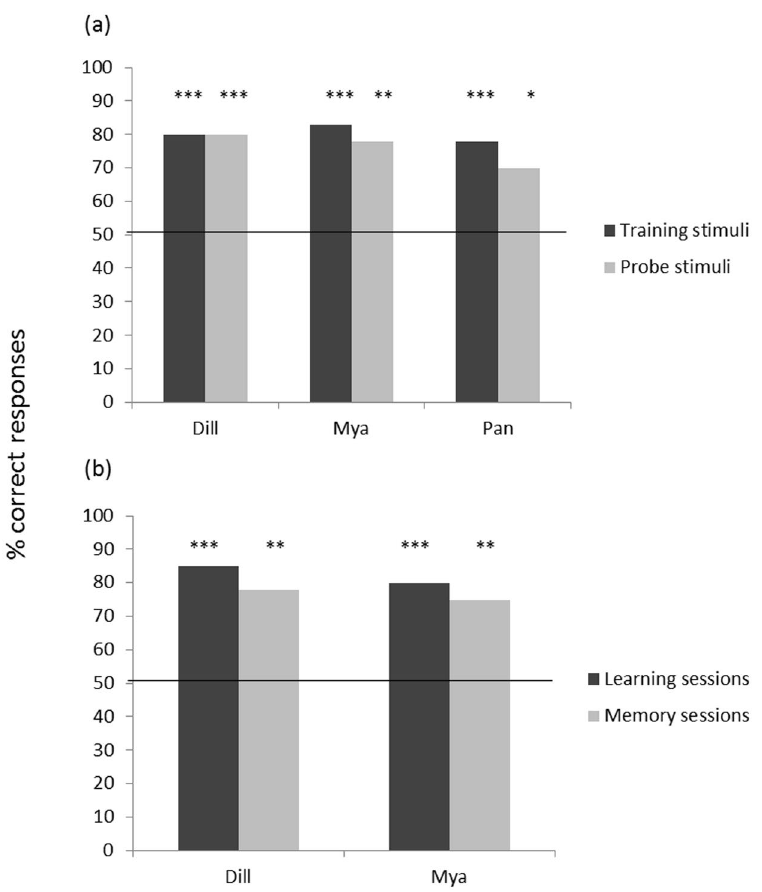
Figure 2. Percentage of correct responses in generalisation test ( a ) and memory test ( b ). Learning sessions represent the performances on the final training session prior to the tests taking place. The solid line represents chance level (50%). Binomial test: * P < 0.05; ** P < 0.01; *** P <